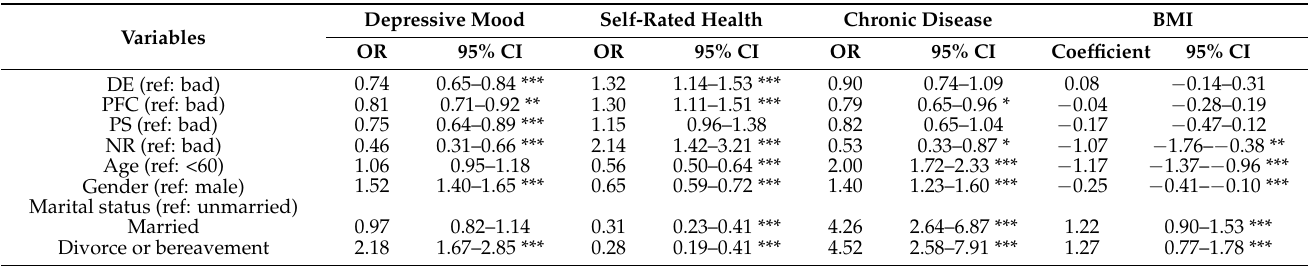
Table 2. The associations between self-perceived neighborhood environment and health status.